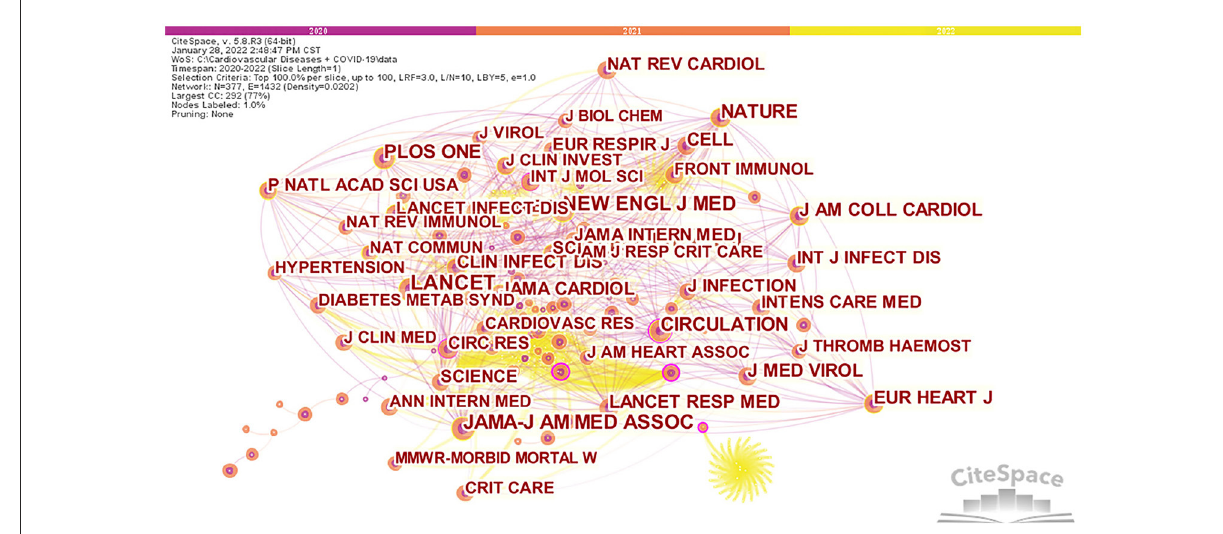
FIGURE5 Network map for citation analysis of co-cited journals on CVDs and COVID-19 research.